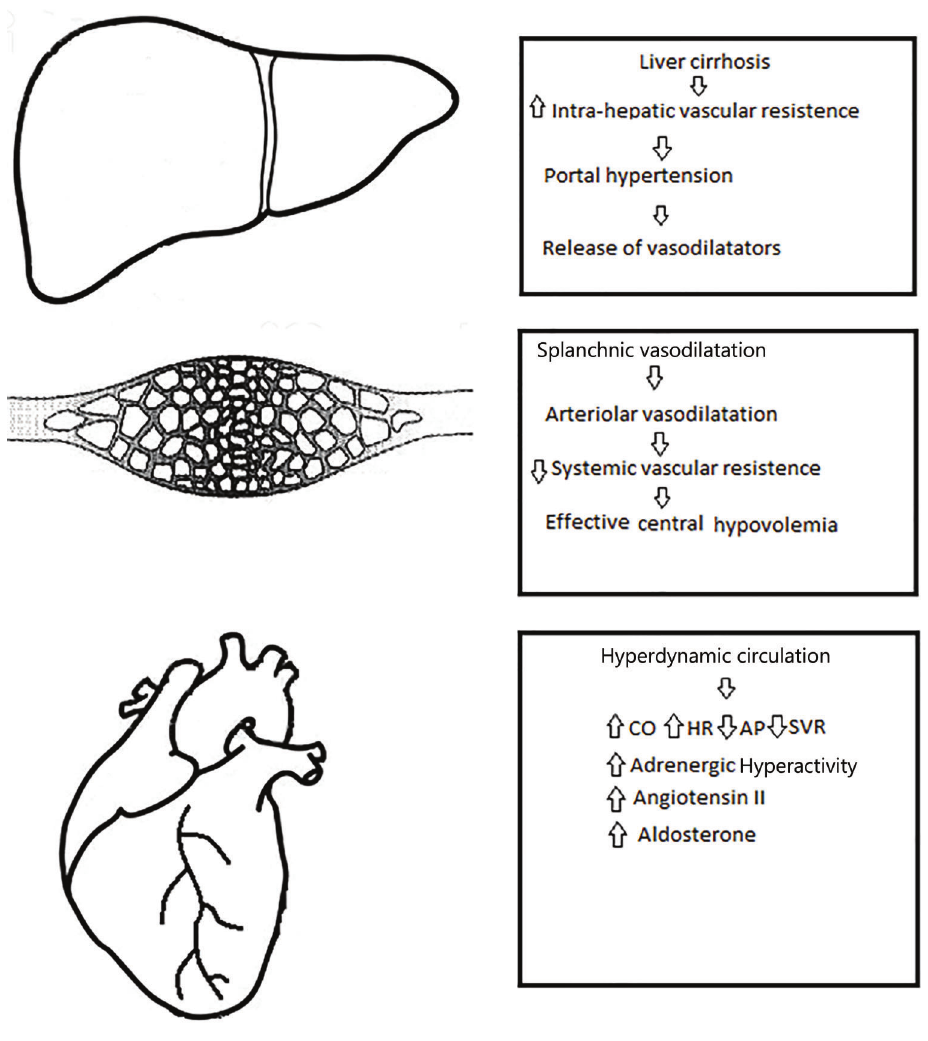
Figure 1. Schematic representation of the pathophysiological mechanisms that lead to liver disease to affect the heart. CO: cardiac output; HR: heart rate; AP: arterial pressure; SVR: systemic vascular